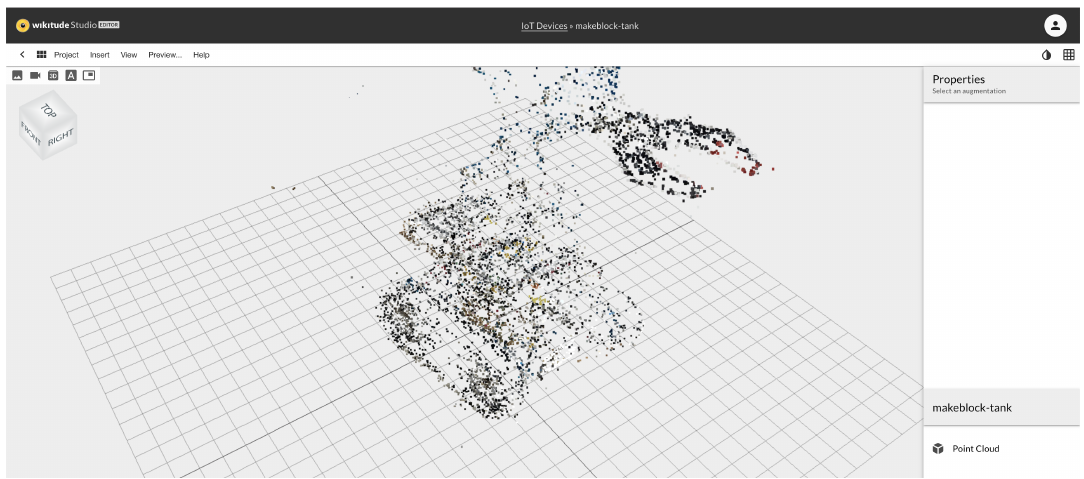
Figure 11. Point Cloud (map of significant points) of the processed 3D object—mechatronic device Makeblock